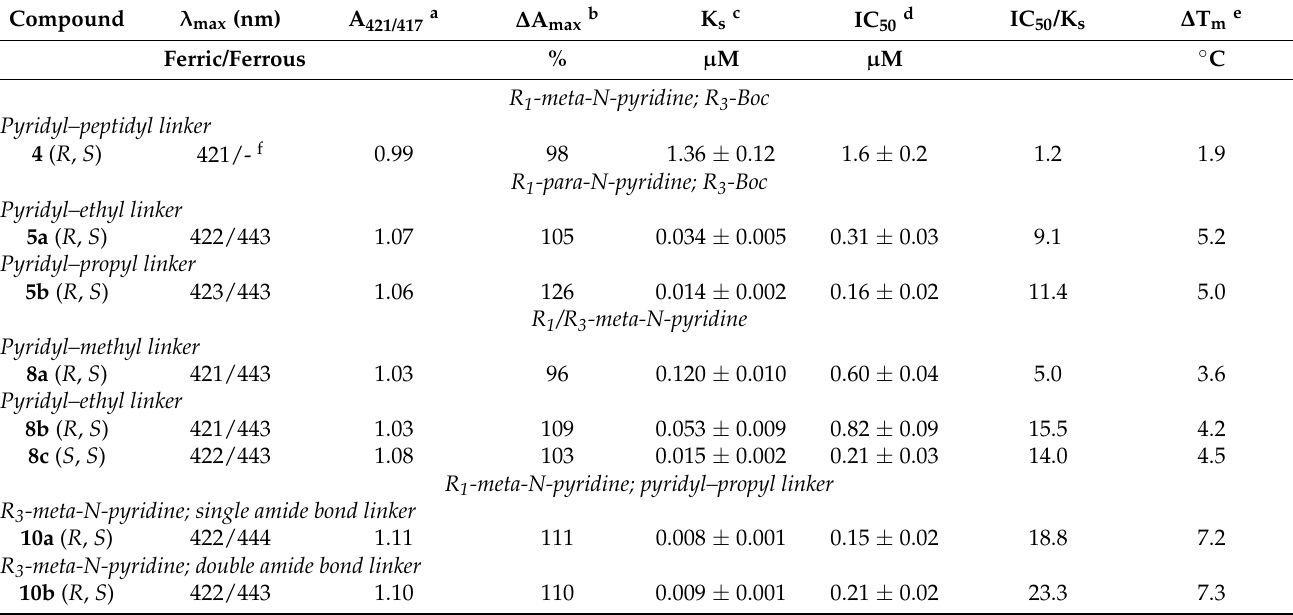
a —Ratio between the absorption maxima of ferric ligand-bound and ligand-free CYP3A4. b —Maximal absorbance change (peak-to-trough in the difference spectrum) relative to that induced by ritonavir. c —Spectral dissociation constants for the inhibitory complexes derived from the titration plots (right insets in Figure 3A–C). d —Inhibitory potency for the BFC debenzylase activity measured in a soluble reconstituted system with cytochrome P450 reductase. e —Ligand-dependent change in the melting temperature of CYP3A4. f —Ferrous CYP3A4- 4 complex does not absorb at 442–443